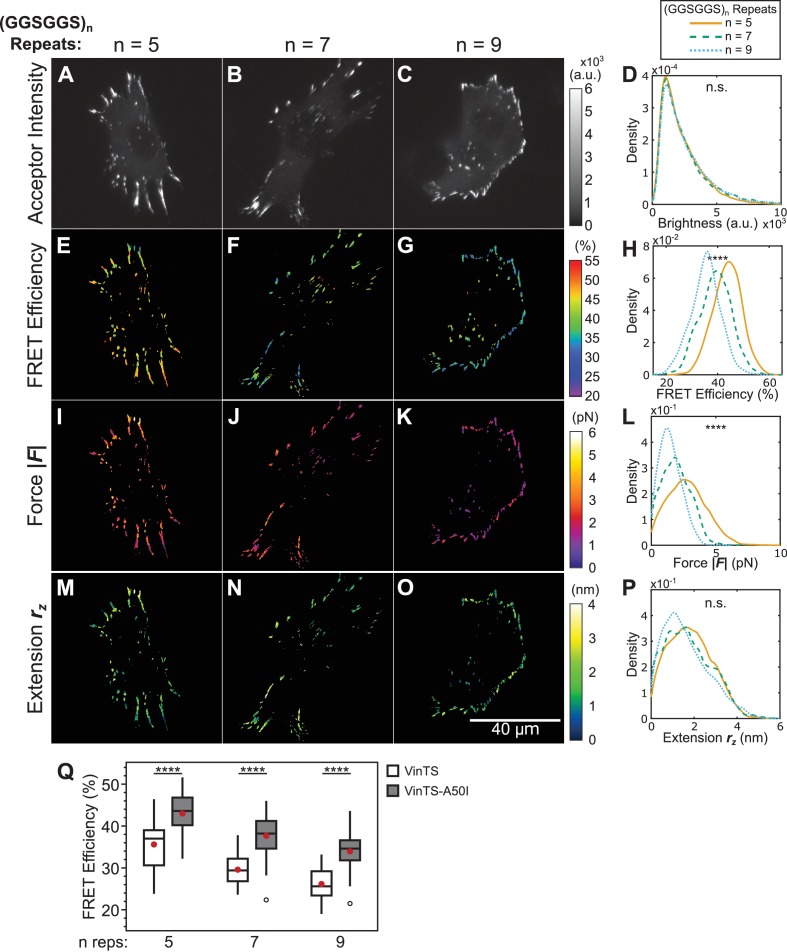
Effect of disrupting vinculin-talin interactions on vinculin extension-control.(A-C) Representative images of the localization of a trio of vinculin tension sensors containing A50I mutations to FAs. (D) Normalized histograms of acceptor intensities at FAs are indistinguishable between the three sensors. (E-G) Representative images of masked FRET efficiency and (H) normalized histograms of average FA FRET reported by each sensor. (I-K) Representative images of forces and (L) normalized histograms of average vinculin force in FAs reported by each sensor. (M-O) Representative images of extension and (P) normalized histograms of average vinculin extension in FAs reported by each sensor. Note that ~16% of FAs exhibited negative forces/extensions and were excluded from the analysis in panels (L and P). All normalized histograms depict data from individual FAs; n = 60, 58, 62 cells and n = 4759, 3393, 4147 FAs for (GGSGGS)5,7,9 extensible domains, respectively; data pooled from three independent experiments; ****p<0.0001, n.s. not significant (p≥0.05), ANOVA. (Q) Quantification of cell-average FRET efficiency in control VinTS-expressing compared to VinTS-A50I -expressing cells; data represents ≥58 cells per condition, pooled from three independent experiments; red filled circle denotes sample mean; ****p<0.0001, Student’s t-test, two-tailed, assuming unequal variances. See Supplementary file 4 for exact p-values and multiple comparisons test details.